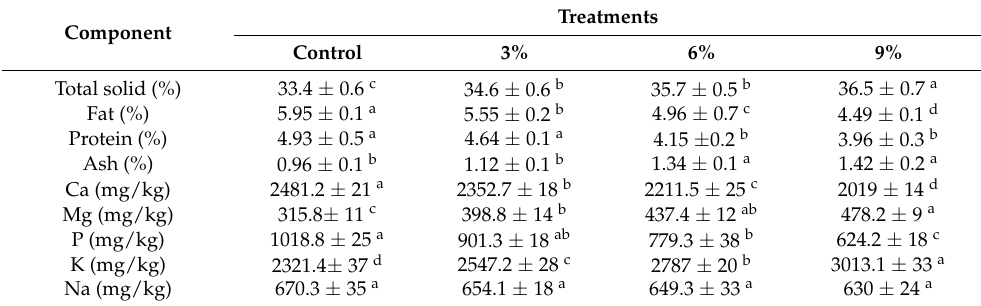
Table 2. Chemical and mineral composition of probiotic ice creams supplemented with CCP.